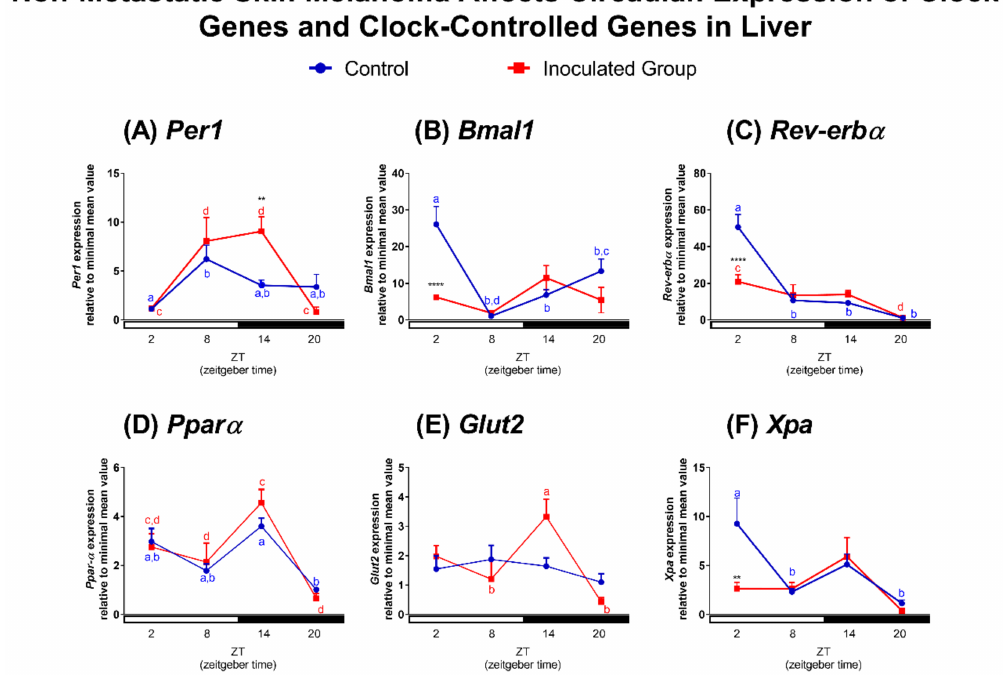
Figure 5. Non-metastatic skin melanoma affects circadian expression of clock genes and clock-controlled genes in liver. Expression of ( A ) Per1 , ( B ) Bmal1 , ( C ) Reverb- α , ( D ) Ppar α , ( E ) Glut2 and ( F ) Xpa in liver of control and tumor-bearing mice. Letters represent significant differences in gene expression within the same group, Two-Way ANOVA followed by Bonferroni post-test. In ( A ) a (cid:54) = b , p < 0.05 and c (cid:54) = d , p < 0.01. In ( B ) a (cid:54) = b , p < 0.001, c (cid:54) = d , p < 0.05. In ( C ) a (cid:54) = b , p < 0.0001, c (cid:54) = d , p < 0.05. In ( D ) a (cid:54) = b and c (cid:54) = d , p < 0.05. In ( E ) a (cid:54) = b , p < 0.05. In ( F ) a (cid:54) = b , p < 0.05. Significant differences between control and tumor-bearing mice were demonstrated by Two-Way ANOVA followed by Bonferroni post-test, and are represented by asterisks having the control liver as reference ** p < 0.01, **** p < 0.0001. Values are presented as the mean expression ( n = 4–6) ± SEM of the gene of interest normalized by 18S RNA, relative to the minimal value found in the control